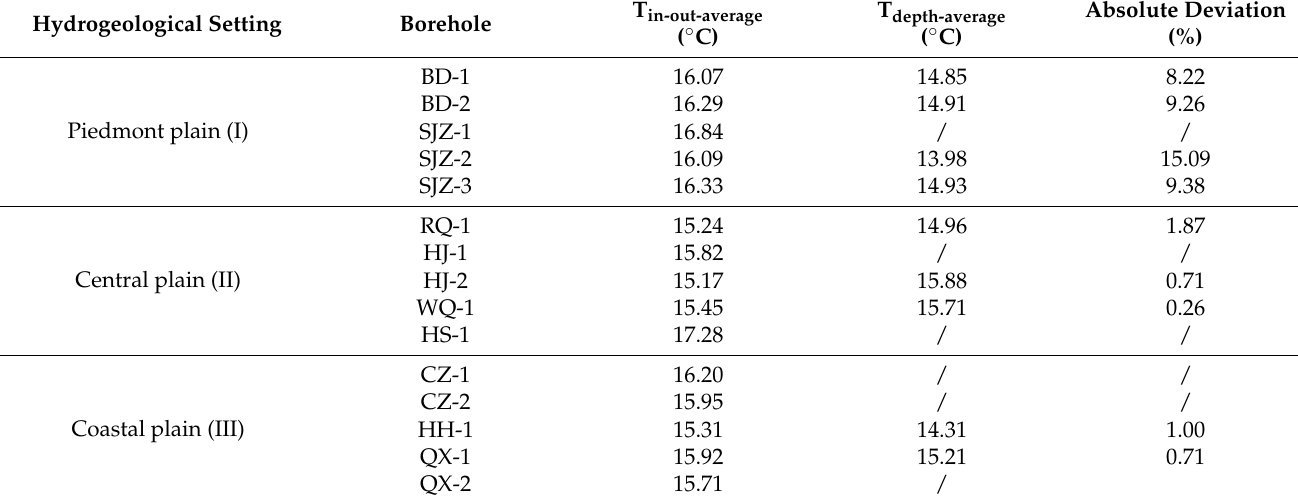
Table 6. Comparison of undisturbed ground temperature based on TRT measurements and temperature